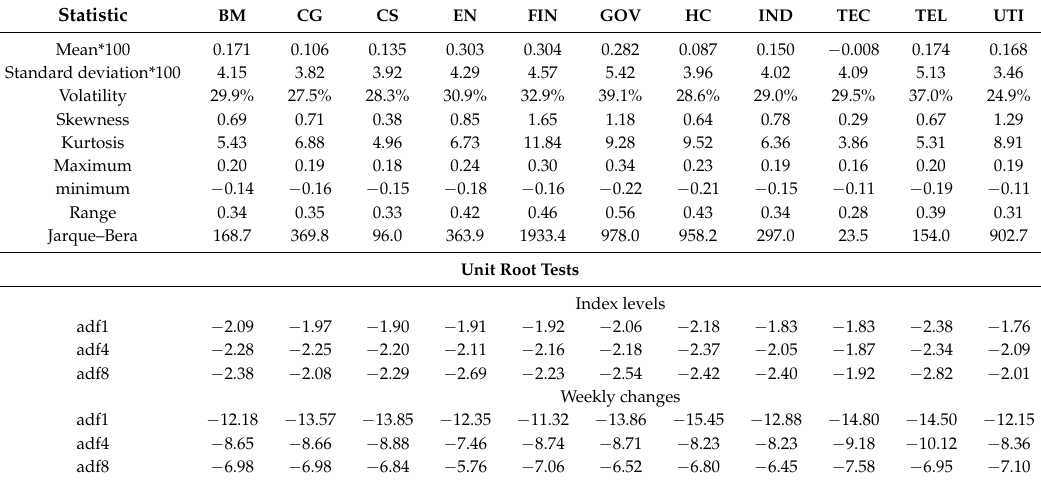
Table 3. Sectorial returns. Main